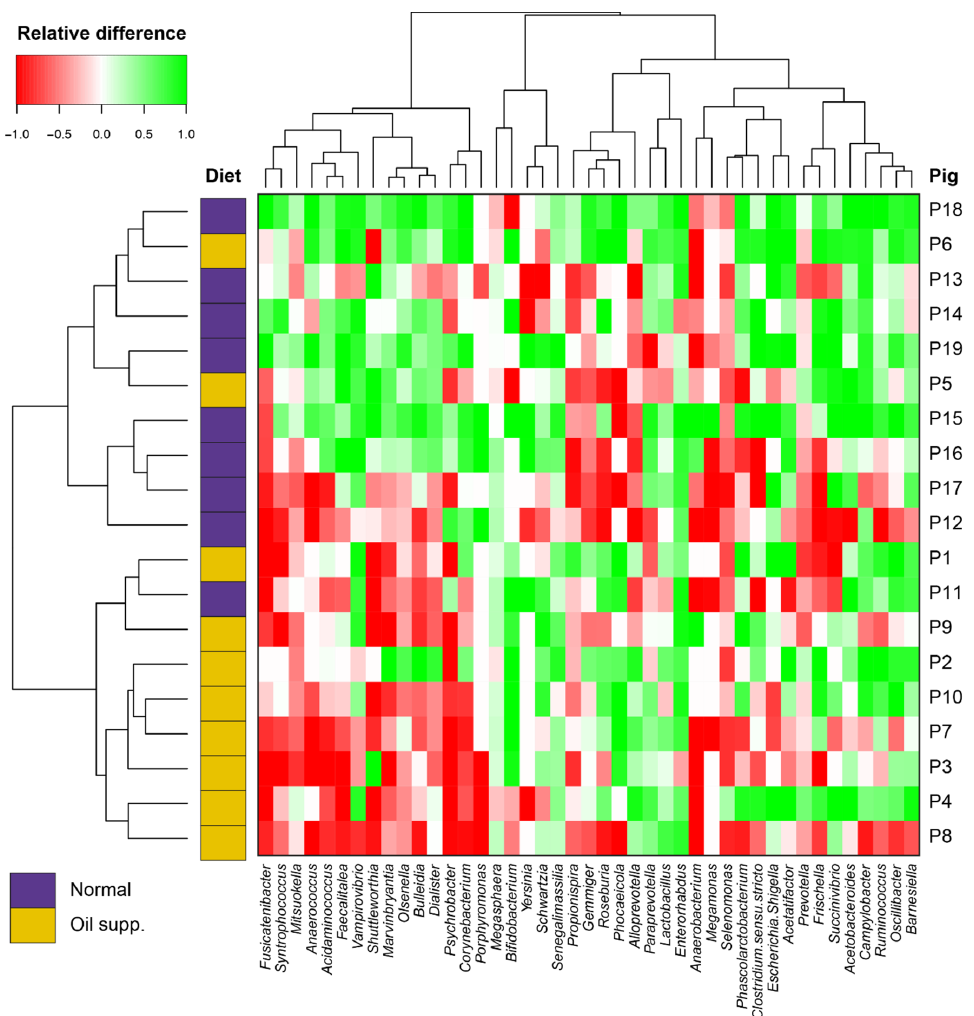
Figure 5. Heatmap of relative differences ((after − before)/(after + before); both 0 = 0) of the 35 most common genera in the rectal swabs of pigs fed a normal diet and a diet supplemented with coconut oil.